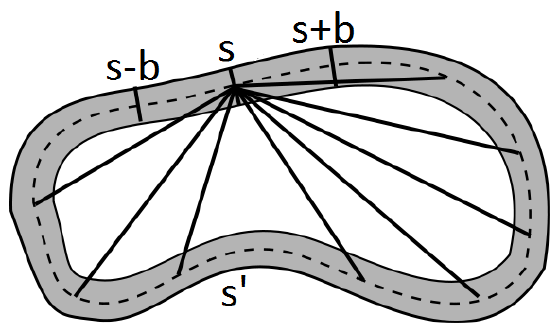
Figure 2: A wire loop and distances relevant for calculating the energy of a disc at s relative to other points in the